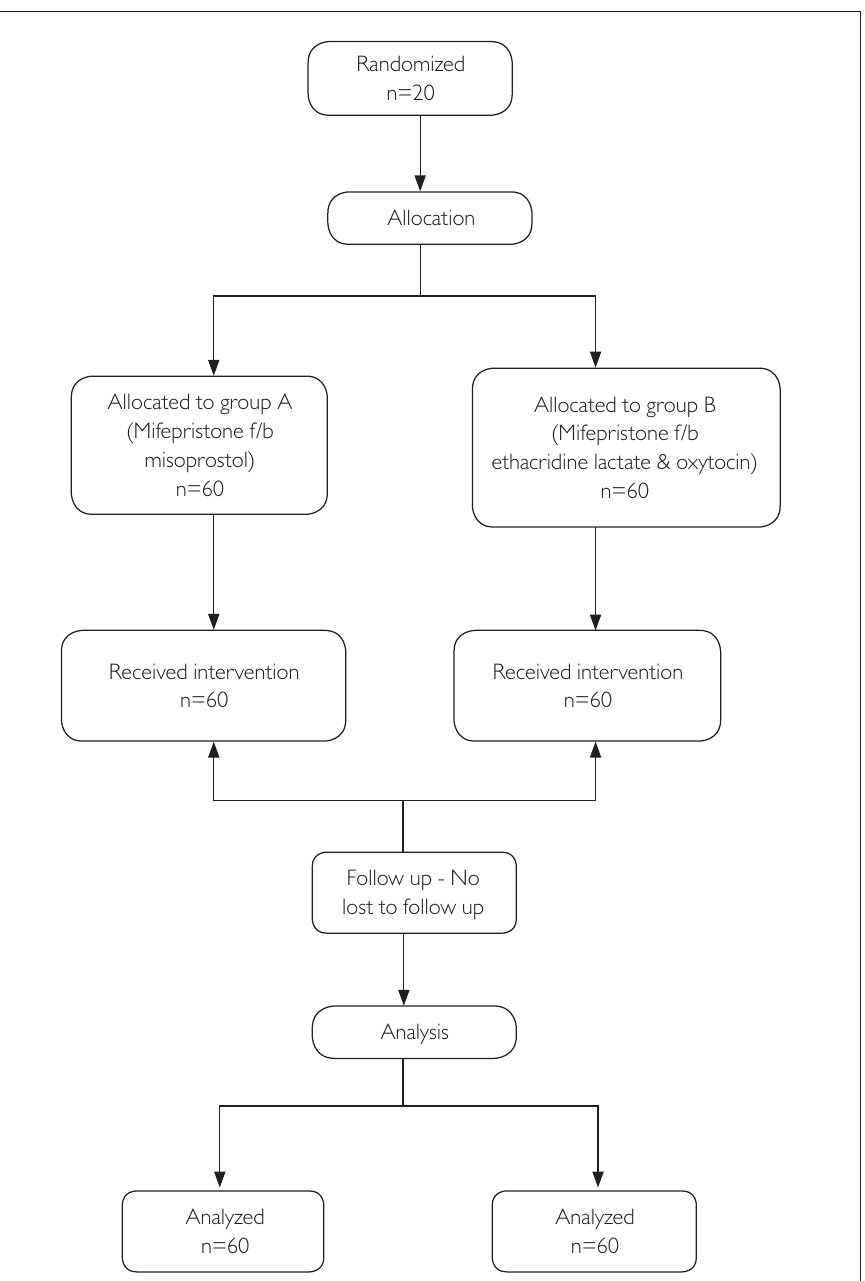
Figure 1. Flow of participants in the